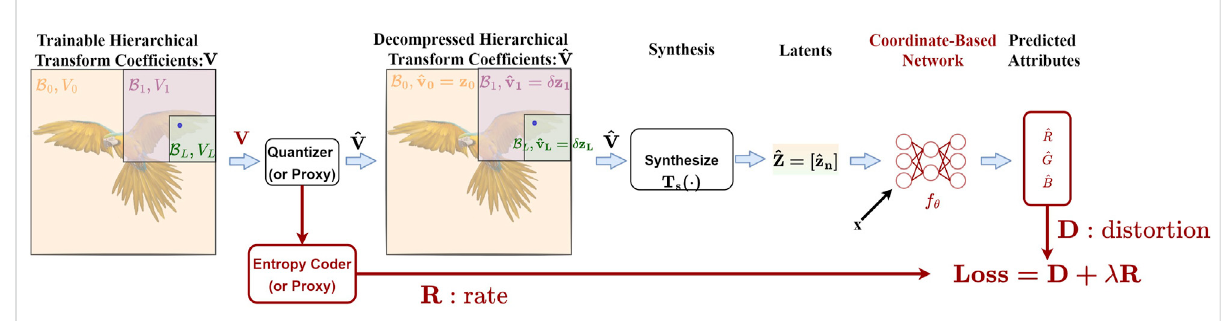
FIGURE 3 Queryingattributesatposition x ∈ R 3 .Theblock B n ( x ) attargetlevel L inwhich x islocatedisidenti fi edbytraversingabinaryspacepartitiontree. The “ learnable ” transform coef fi cients V are fi rst quantized by rounding to obtain ^ V (cid:1) (cid:3) V (cid:4) , and then the latent vectors are reconstructed as ^ Z (cid:1) T s ^ V . V isoptimizedbyback-propagating D ( θ , Z )+ λ R ( θ , Z )throughallthecomponentsinthe fi gure.Thepipelineusesdifferentiableproxiesforthequantizer and entropy coder. In Figure 4, we give more details on the quantization and the orthonormalization steps, which are omitted in this fi gure for